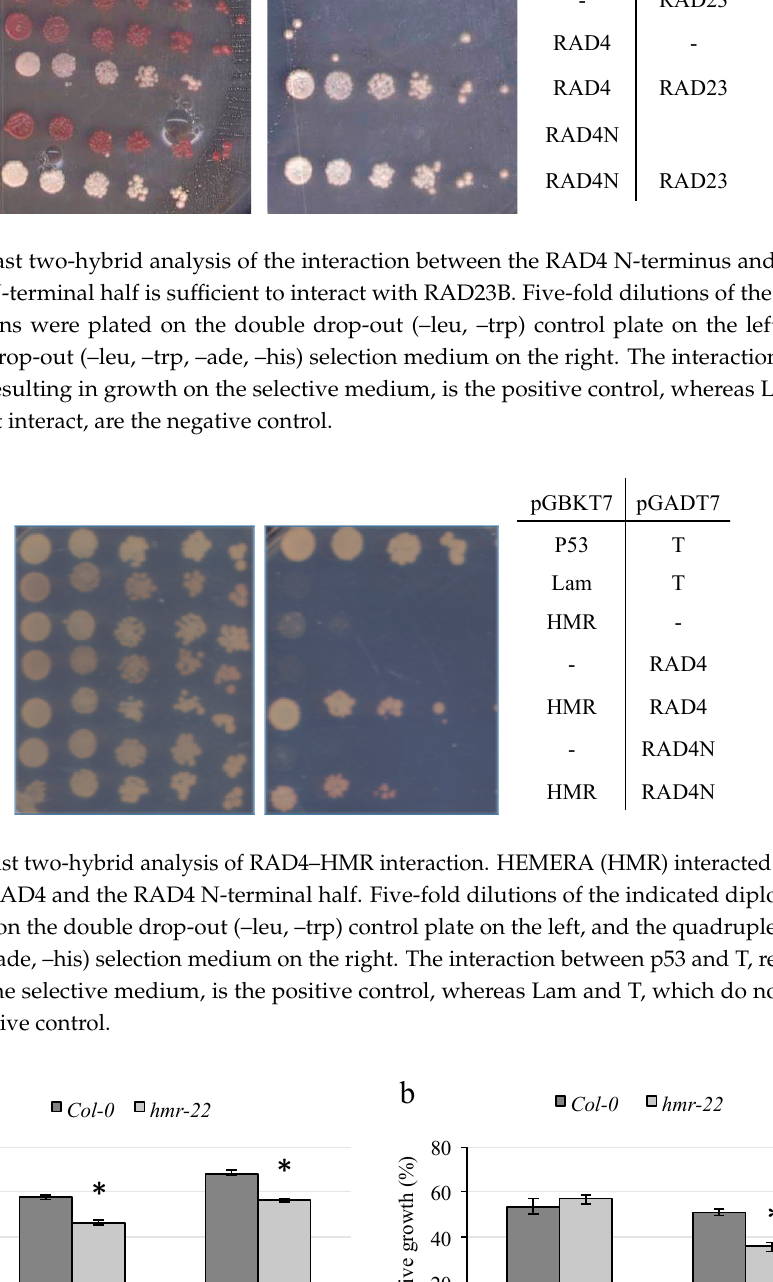
Figure 5. The mutant hmr exhibits increased UV sensitivity. ( a ) Hypocotyl and root growth in dark-incubated seedlings analyzed 3 days after UV treatment, expressed as relative to the untreated controls ( n = 20). ( b ) Root growth in light- and dark-incubated seedlings analyzed 2 days after UV treatment, expressed as relative to the untreated controls ( n = 20). The values are means ± SE, * = p < 0.05 for the mutant versus Col-0 wild type in the same